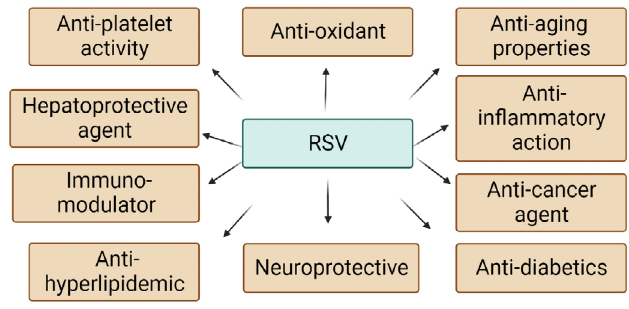
Figure 2. Biological effects of